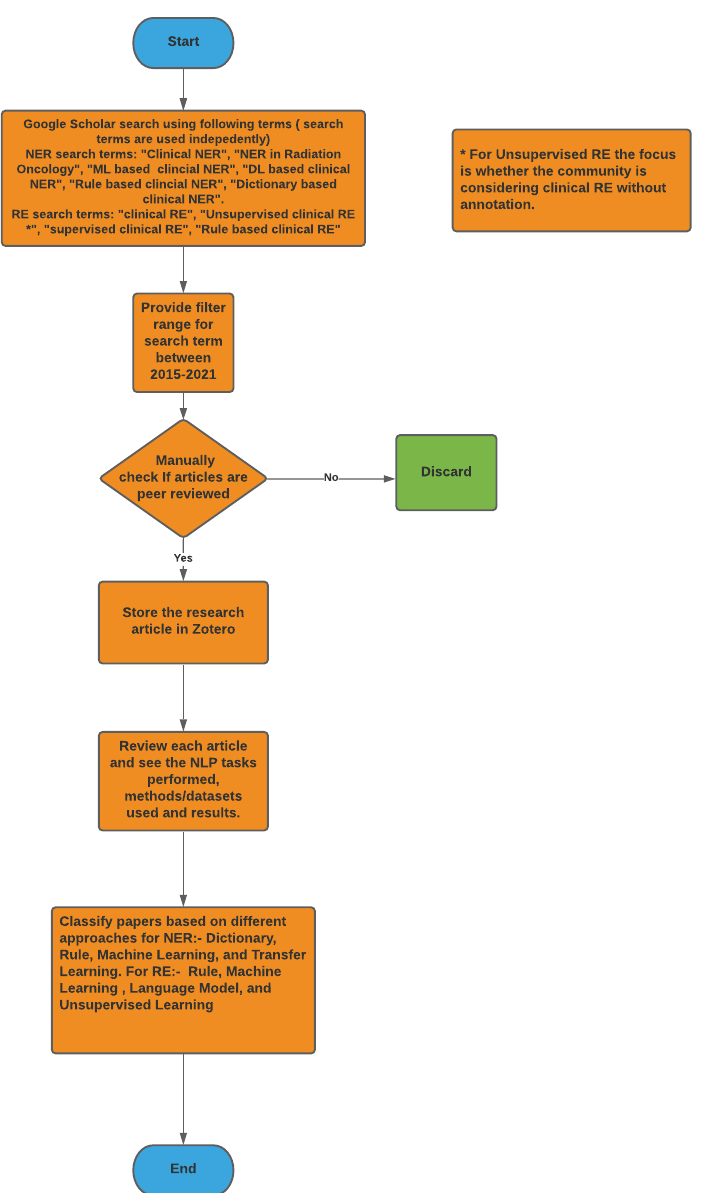
Figure 2. Methodology flowchart used here for both NER and RE to select